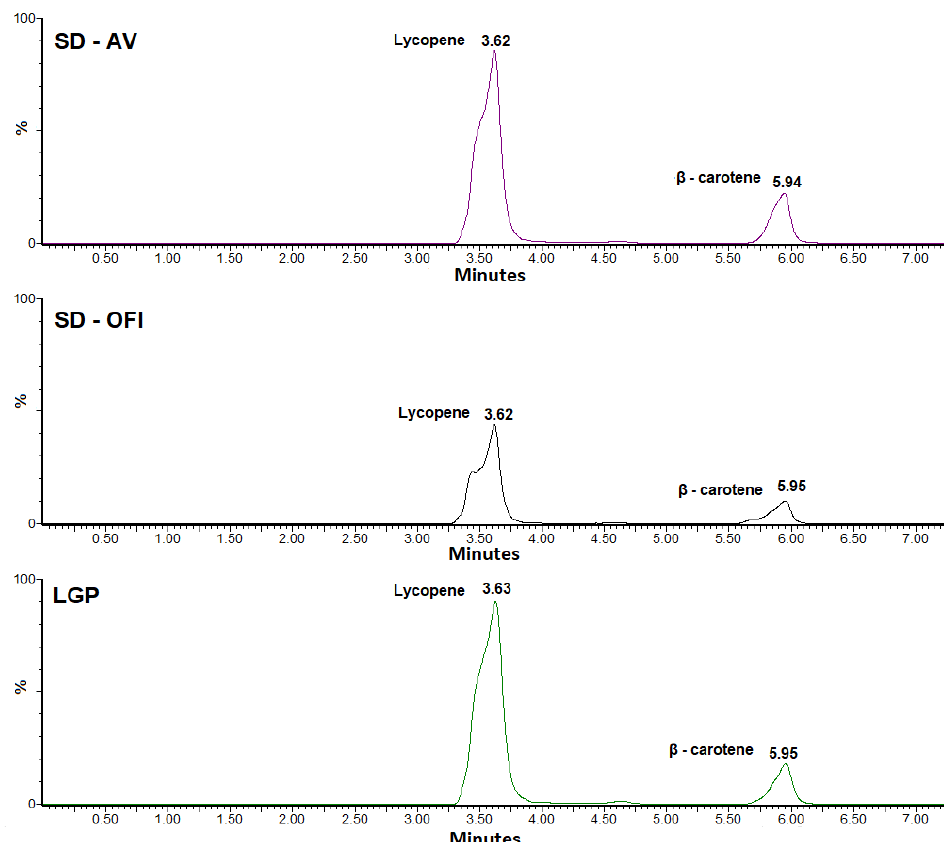
Figure 1. HPLC-MS chromatograms of SD-OFI and SD-AV guava pulp microcapsules and lyophilized guava pulp (LGP).